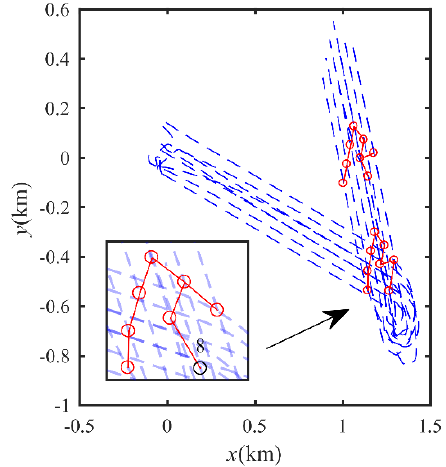
Figure 12. Position errors (test 3).